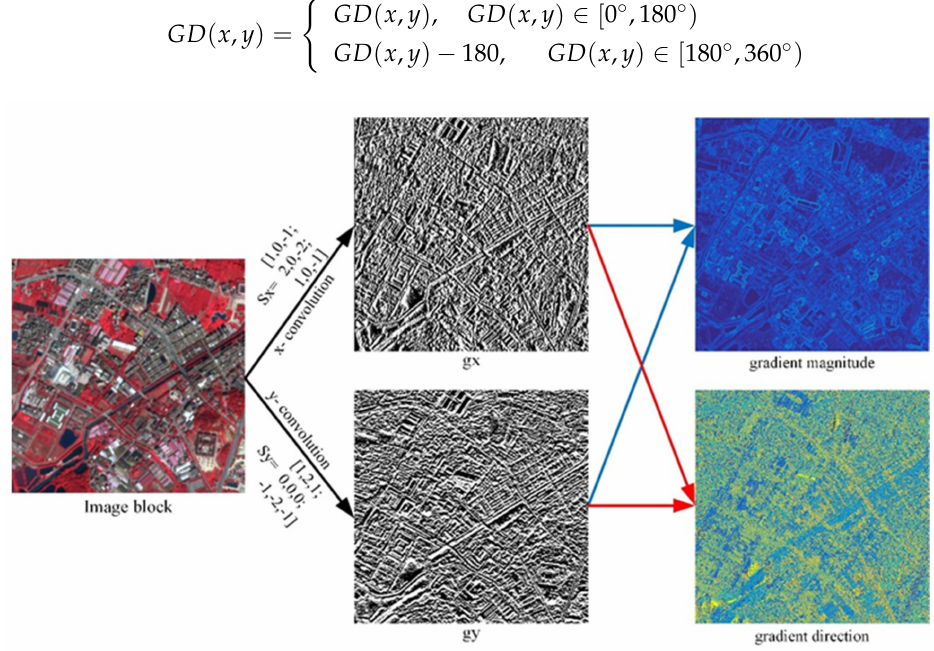
Figure 2. The calculation process of gradient magnitude and gradient